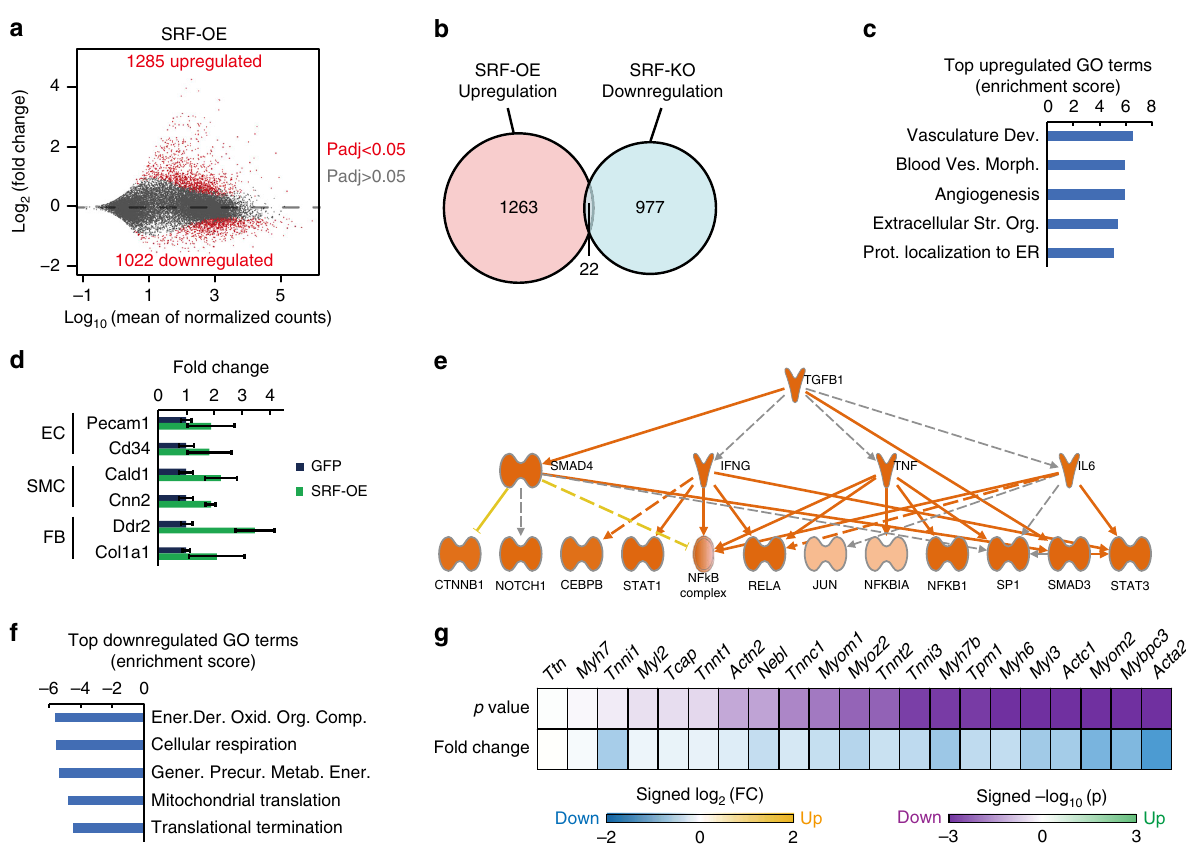
Fig. 8 SRF overexpression perturbs the transcriptional program in maturing CMs. a SRF overexpression and control P14 CMs were FACS sorted and analyzed by RNA-seq. MA plots showed dramatic transcriptional dysregulation. Signi fi cantly dysregulated genes ( P adj < 0.05) were dots in red. b Up- regulated genes upon SRF overexpression showed little overlap with genes down-regulated upon Srf KO at the same stage, as viewed by Venn diagram. c Gene ontology terms enriched among genes up-regulated upon SRF overexpression. The GSEA normalized enrichment scores for the top 5 terms were plotted. d Selected markers of endothelial cells (EC), smooth muscle cells (SMC), and fi broblasts (FB) that were up-regulated by SRF overexpression. e IPA upstream regulator analysis showed up-regulation of in fl ammatory response pathways upon SRF overexpression. The color of the lines signi fi es the expected direction of effect between two nodes. Blue represents predicted inhibition and orange represents predicted activation. Yellow signi fi es inconsistency between the gene expression in the data set and the annotated relationship. Gray indicates no prediction. Solid and dashed lines indicate direct and indirect interactions, respectively. f Gene ontology terms enriched among genes down-regulated upon SRF overexpression. g Statistical analyses of the differential expression of major sarcomere genes. Fold changes and P values were plotted in blue-yellow and magenta-green color scales, respectively. Differential expression analysis P values were calculated by DESeq2